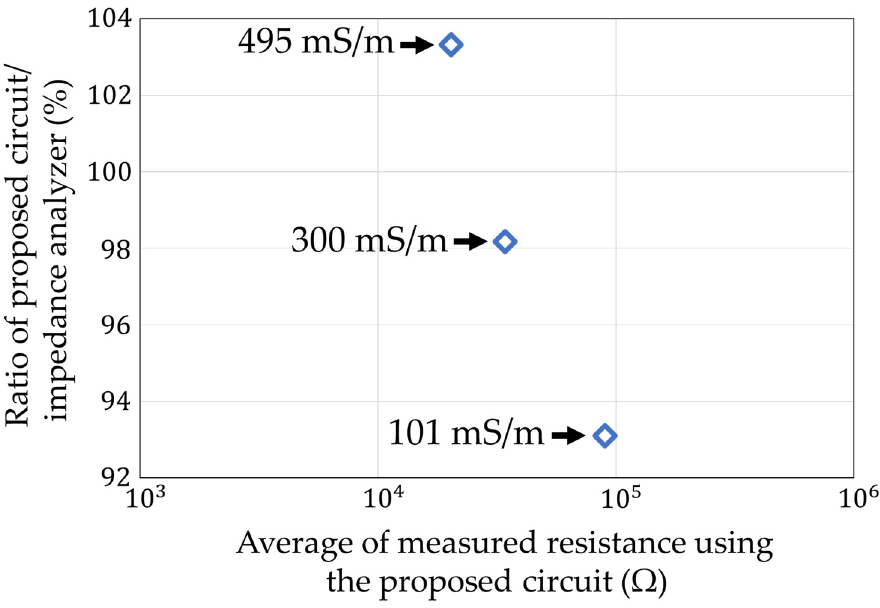
Figure 26. Deviation of the measurements with the impedance analyzer in Figure 25.